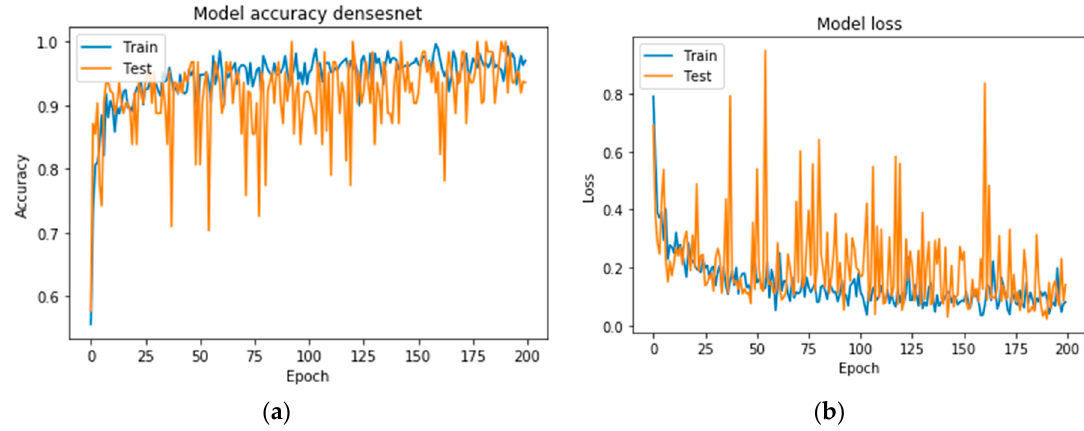
Figure A3. Precision curves for DenseNet ( a ) accuracy and ( b ) loss.